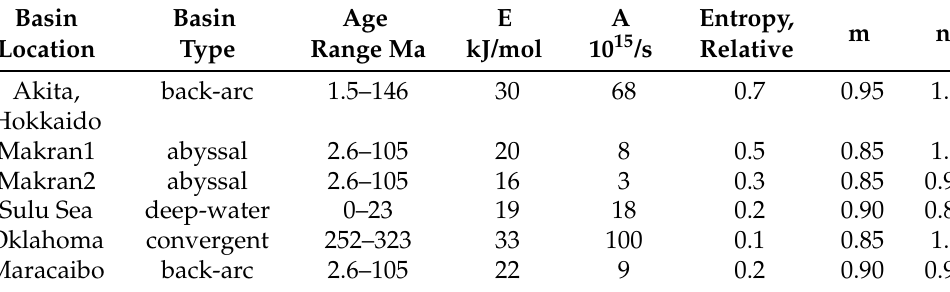
Table 2. Derived variables for initial